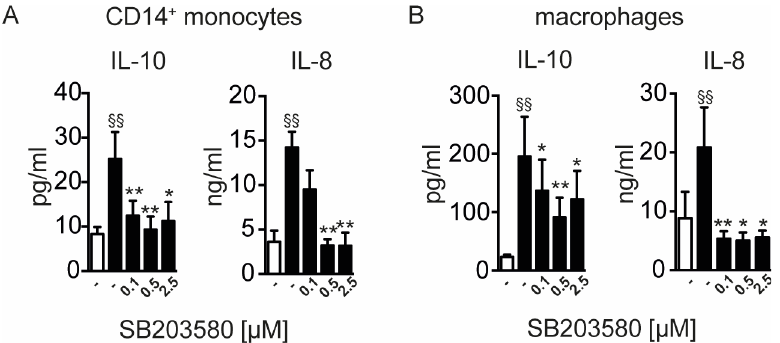
Fig 6. Induction of IL-10 and IL-8 by rBmCPI-2 in human monocytes and macrophages is dependent on p38. Human monocytes (A) and macrophages (B) were stimulatedwith 20 μ g/ml of rBmCPI-2 for 24 h with variousconcentrations of p38 inhibitor. Cytokines in the supernatantswere detected by ELISA. Data are from 7–9 donorsand shown as mean ± SEM. Statistical analysiswas done using the Wilcoxon matched-pairs signedrank test. Values statistically different from the unstimulated control are depictedas § p < 0.05and §§ p < 0.01.Values statistically different from BmCPI-2-stimulatedmonocytesare depictedas * p < 0.05and ** p <